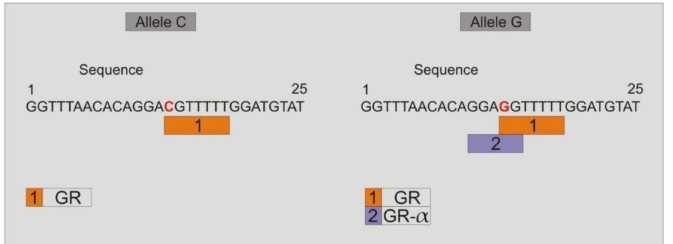
Figure 6. Study of the transcription factor binding sites in the DNA sequence where the TLR4 -rs11536865 is located. When the allele C is present only the glucocorticoid receptor transcription factor (GR) joins to the site, but when the allele G is present, the transcription factors GR and GR- α join to the